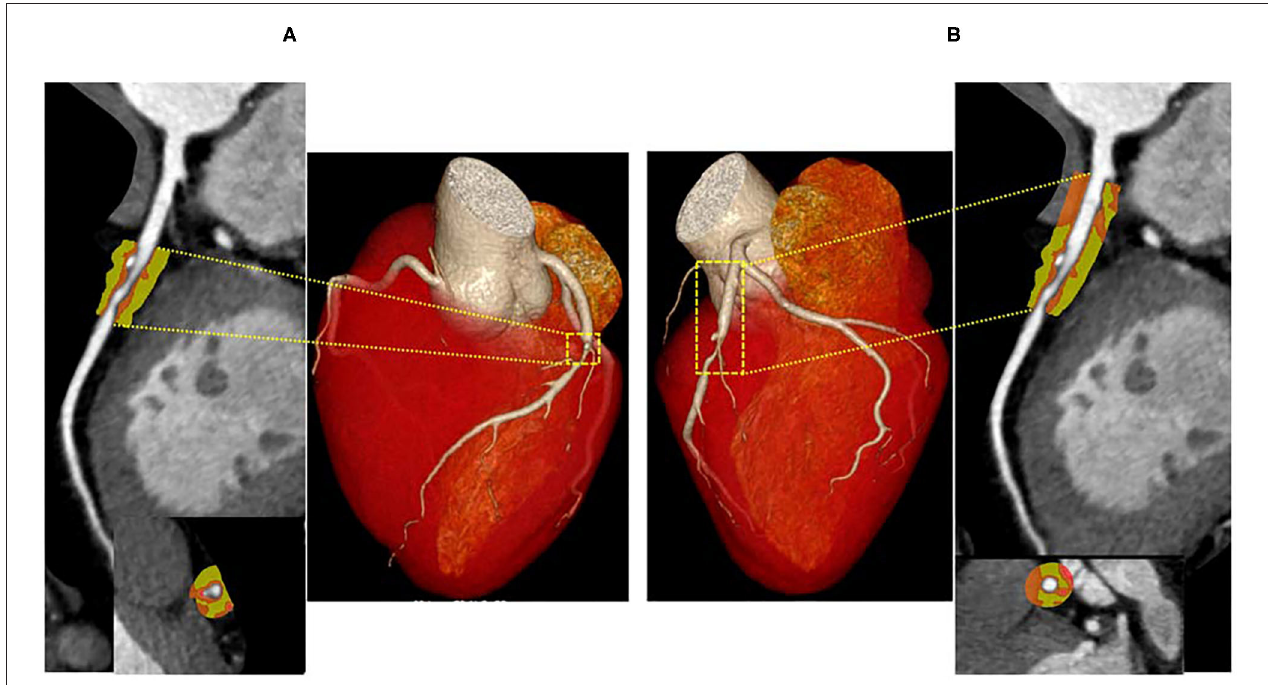
FIGURE 1 | Representative CCTA image of PCAT around LAD. A hemodynamically significant stenosis (FFR = 0.73) in the middle segment of LAD. PCAT CT attenuation was defined as the mean CT attenuated value within a radial distance equal to the diameter of the vessel. The length of the lesion-based PCAT was defined from the proximal to the distal shoulder of the lesion (A) , the vessel-based PCAT was focused on the proximal 40-mm segments of all three major epicardial coronary vessels (10 to 50mm from right coronary artery ostium) (B) . LAD, left anterior descending artery; PCAT, pericoronary adipose